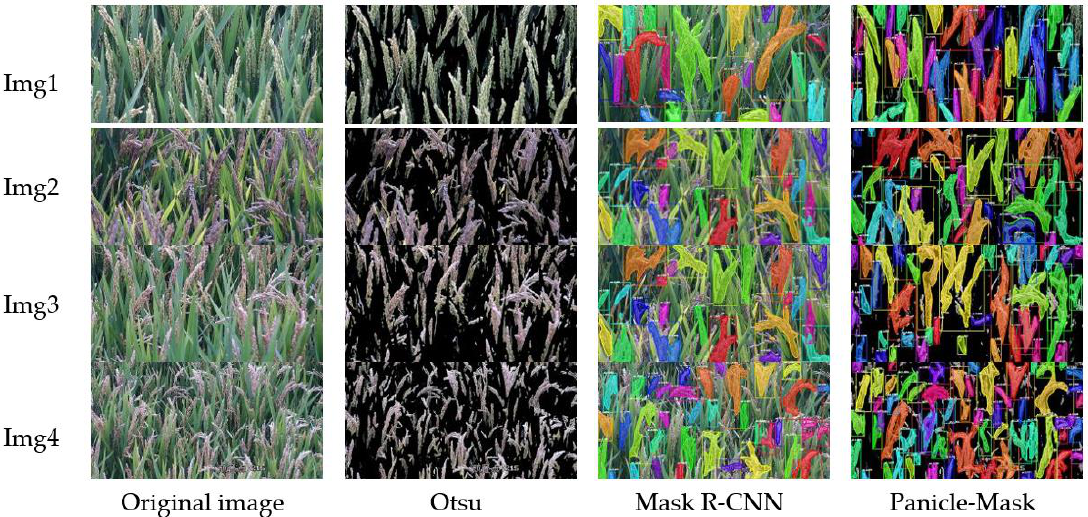
Figure 6. Examples of detection results using different methods.